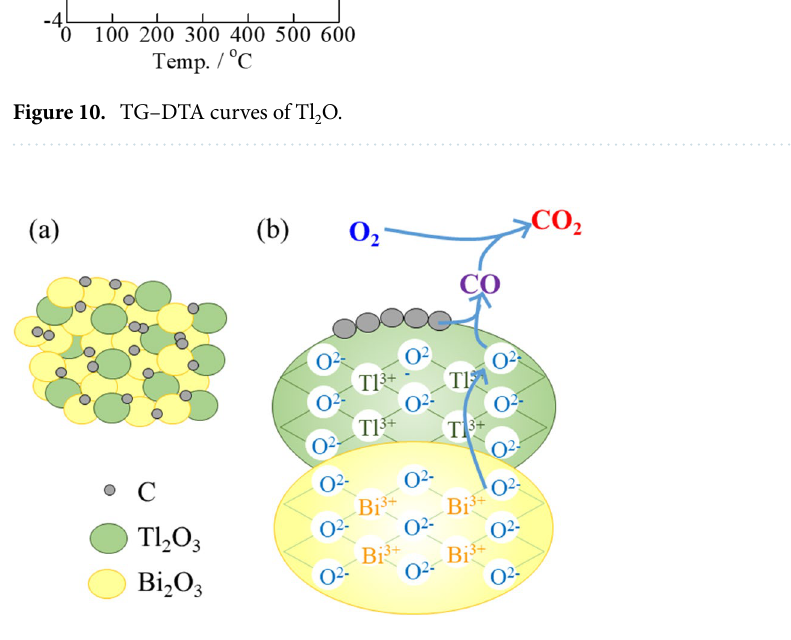
Figure 11. Schematic illustrations of (a) the carbon and Tl 2 O 3 ‒ Bi 2 O 3 mixture and (b) the Tl 2 O 3 -modified